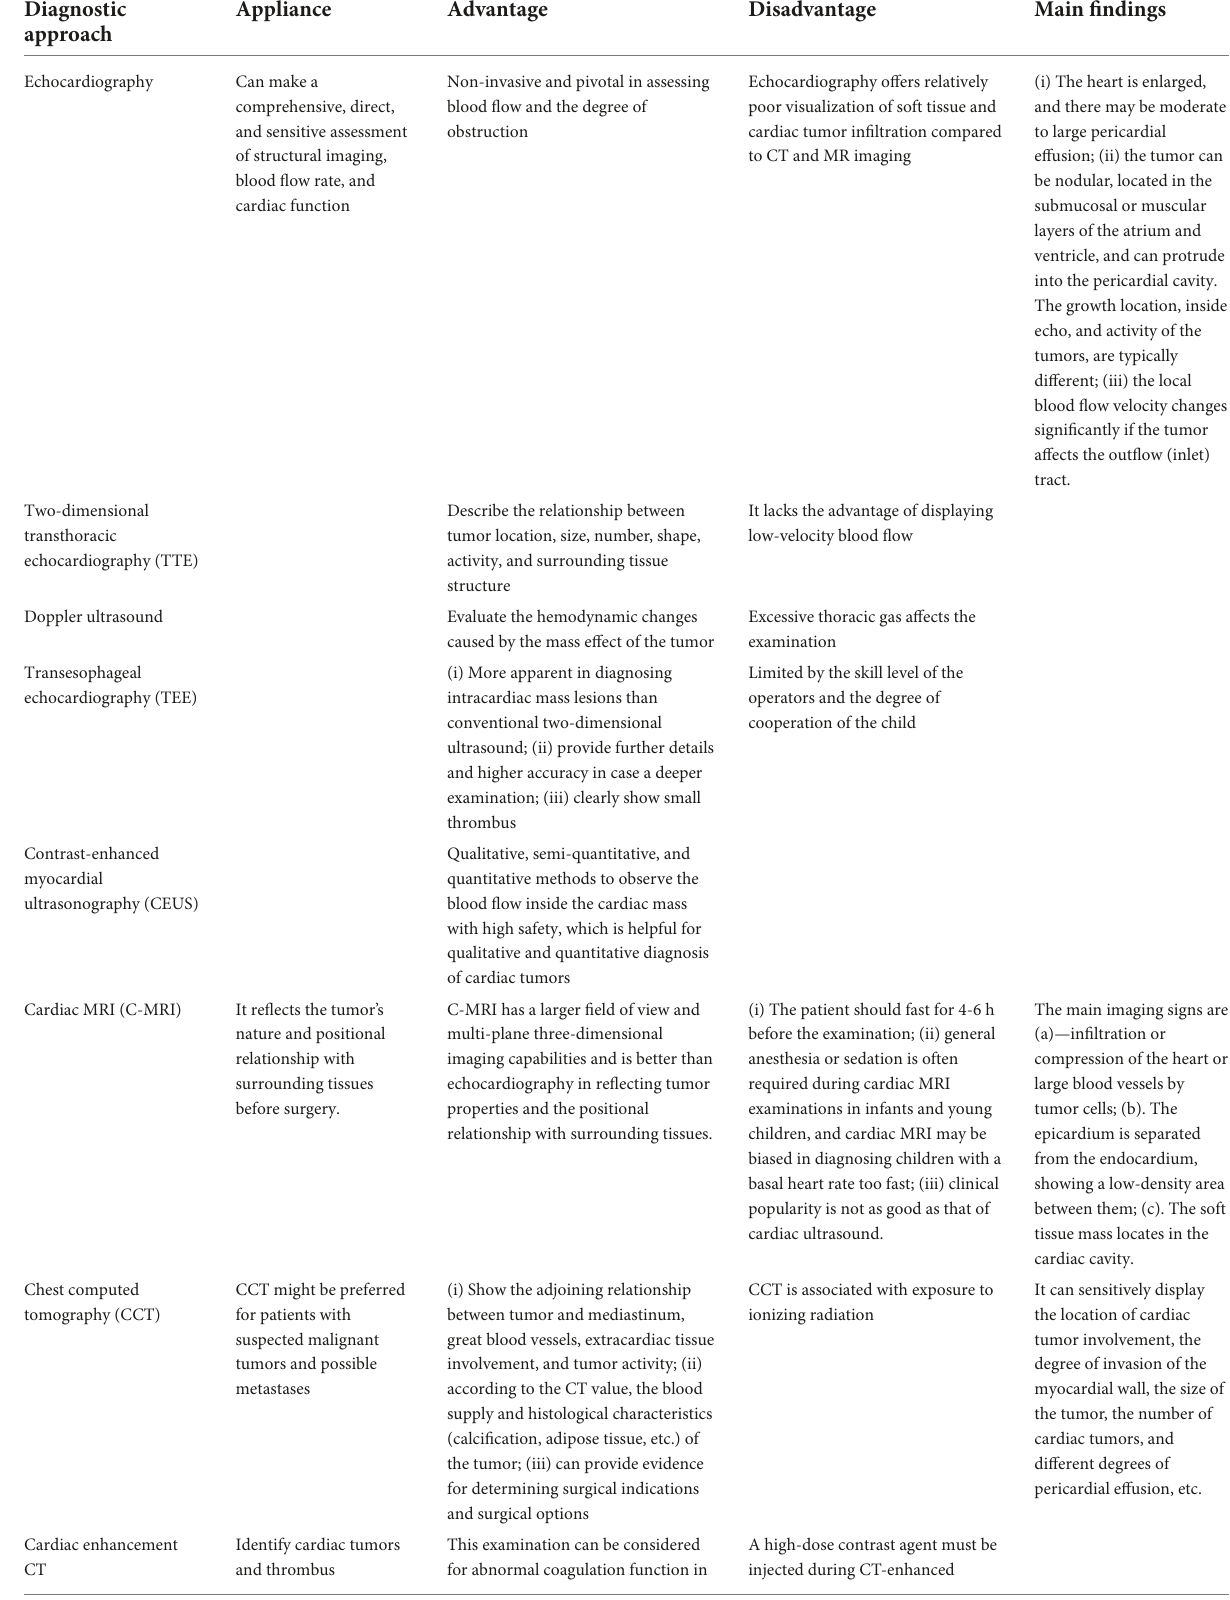
TABLE 1 Outline advantages/disadvantages, indications, and main findings of different investigative